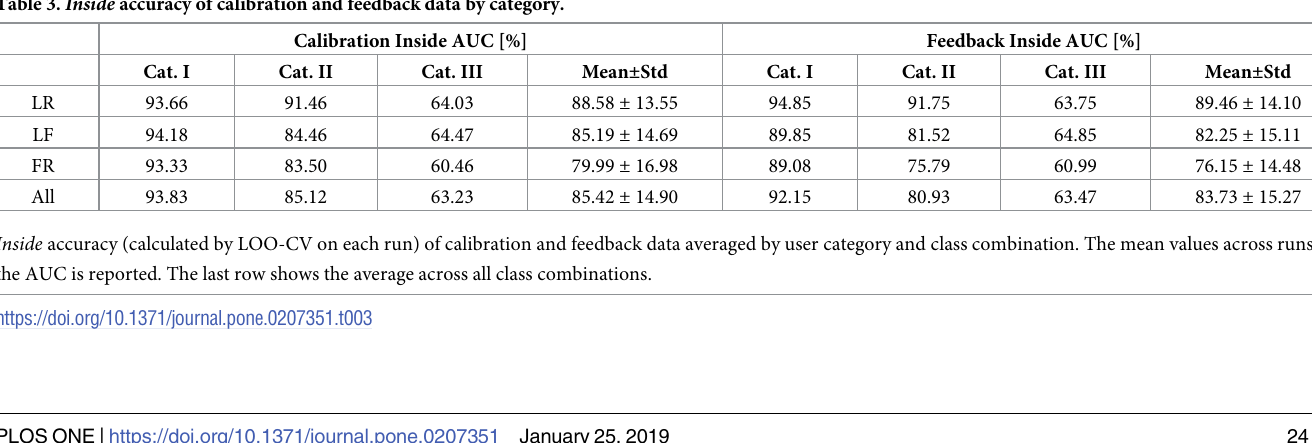
Table 3. Inside accuracy of calibration and feedback data by category.